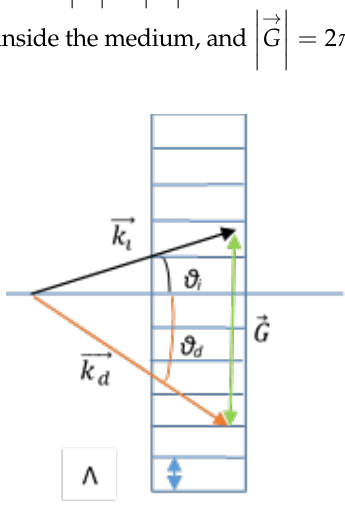
Figure 3. Bragg condition for an unslanted